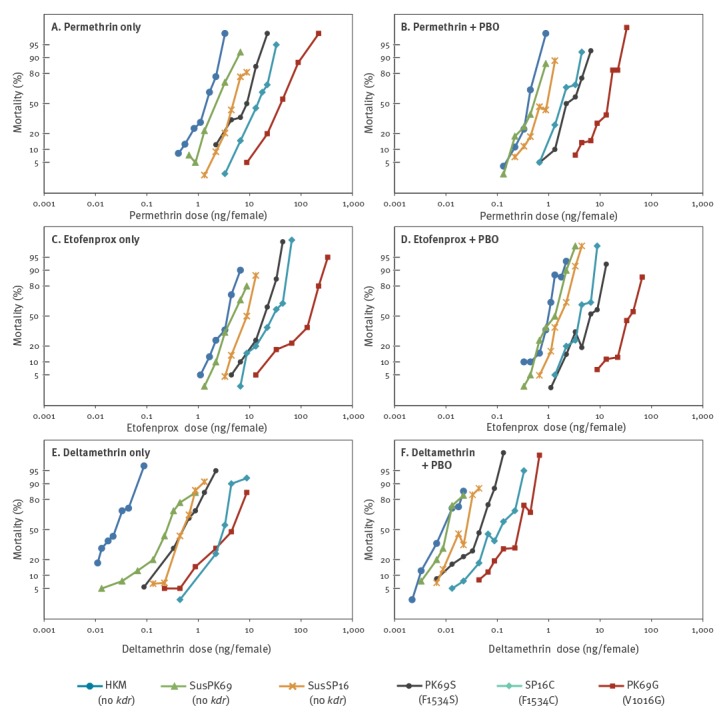
Log dosage-probit mortality lines of six Aedes albopictus strains topically exposed to: (A, B) permethrin, (C, D) etofenprox and (E, F) deltamethrin, September 2015–October 2017 (n = 12,145 mosquitoes)